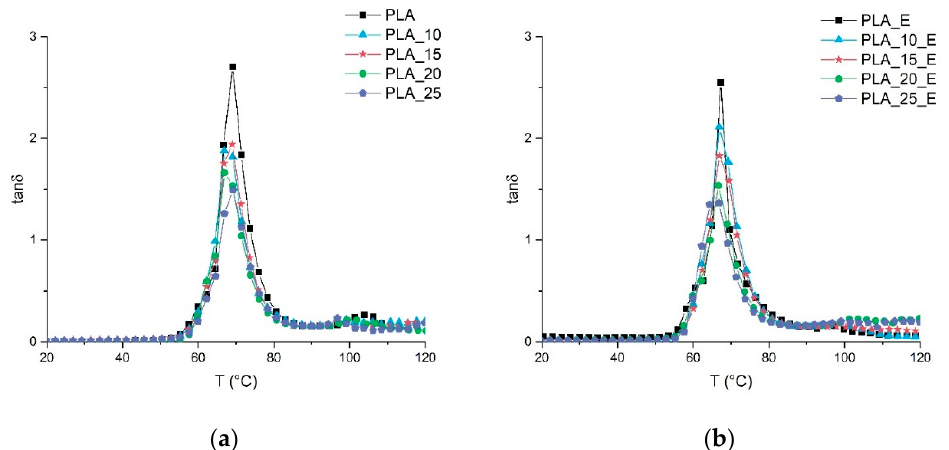
Figure 4. Tan δ of PLA-Arbocel biocomposites as a function of temperature: ( a ) composite system without Einar, ( b ) composite system with Einar.